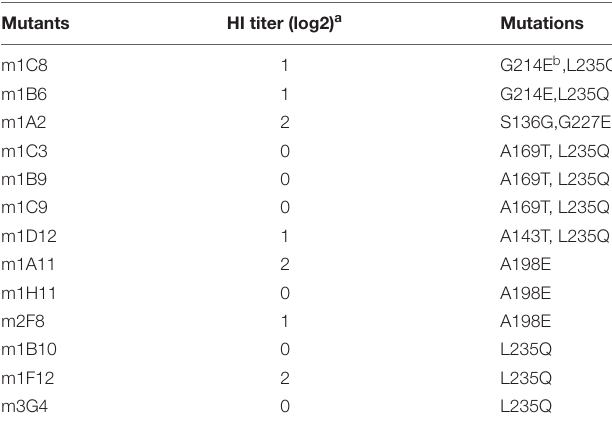
FIGURE 2 | Broad reaction of the strip for H7 subtype AIVs isolated from 2013 to 2017. 1–9: isolated in 2013; 10–17: isolated in 2014; 18, 19: isolated in 2015; 20, 21: isolated in 2016; 22: isolated in 2017; 23: A H7N9 HPAIV stain A/chicken/Hebei/XT-3/2017 (CK/XT-3/2017).